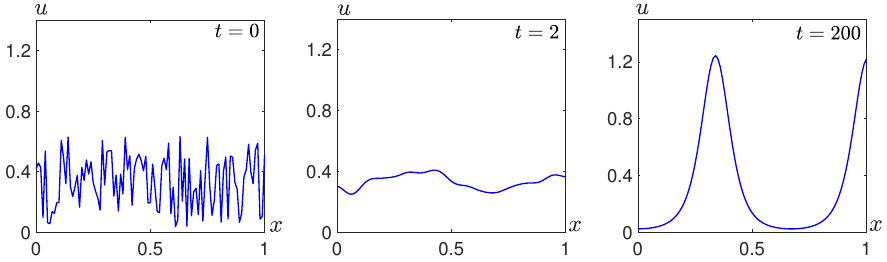
Figure 2. Pattern formation in Systems (1), (2) from the randomly generated initial state. Here, a = d = e = 0.5, b = c = 1, D u = 5 × 10 − 4 , D v = 0.02, and ε =